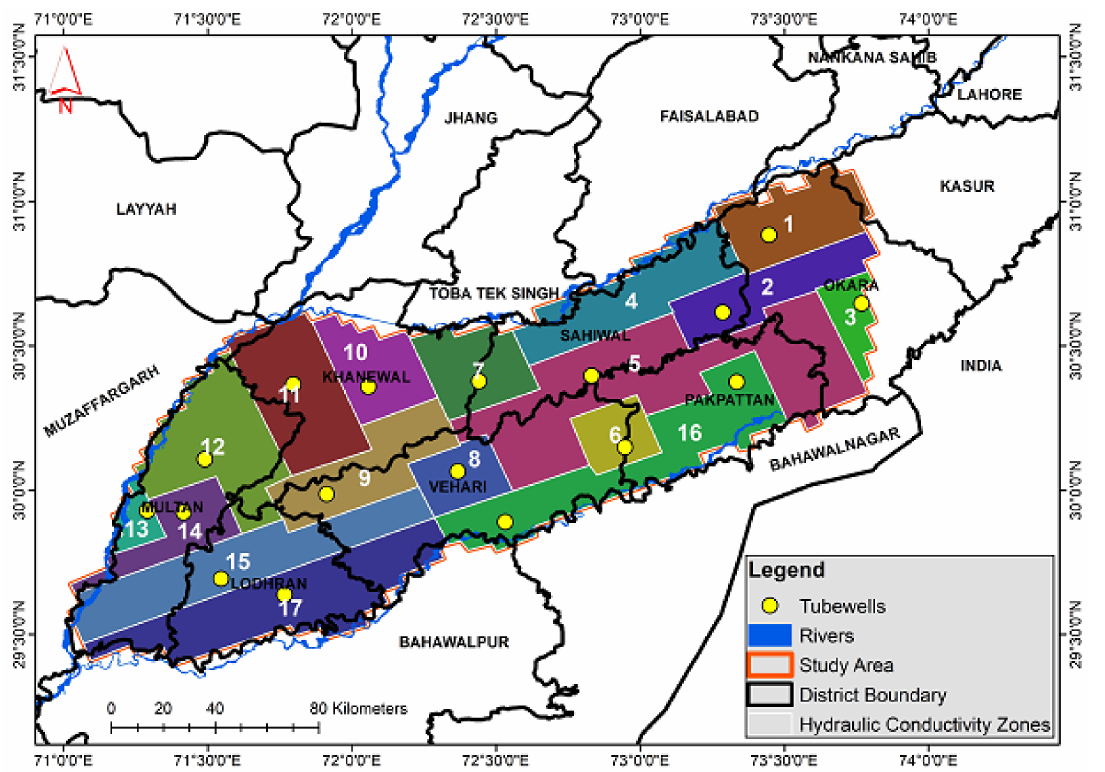
Figure 6. Zonation of hydraulic conductivity (K pump ) of the aquifer based on pumping test